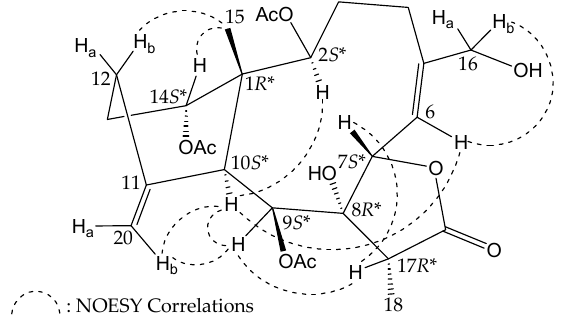
Figure 3. Selected protons with key NOESY correlations of 2 .